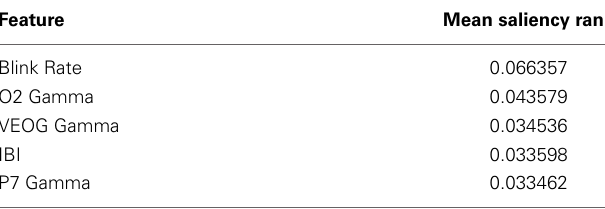
Table 3 | Mean saliency rank of features (top 5 of 37).